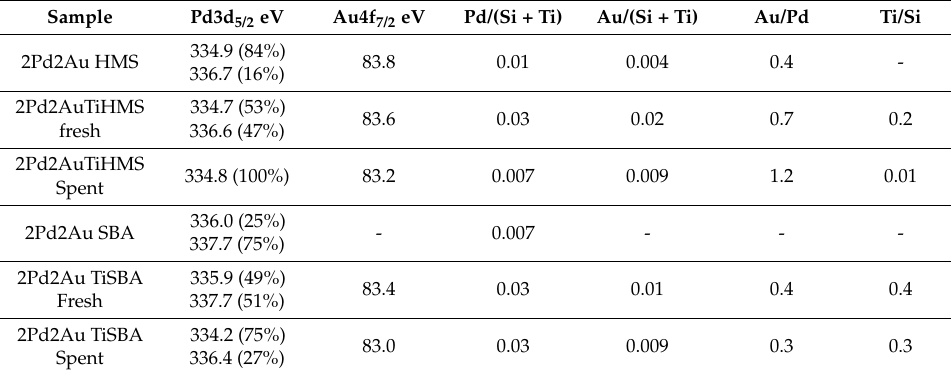
Table 5. XPS data for 2Pd2Au on HMS/TiHMS or SBA/TiSBA support.